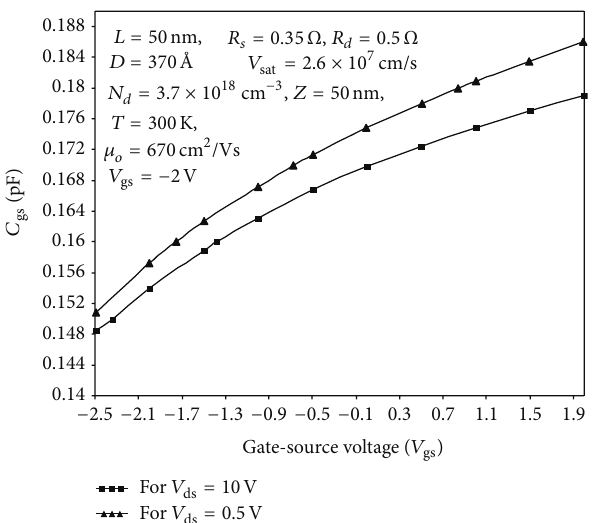
Figure 8: Variation of 𝐶 with gate voltage. gs